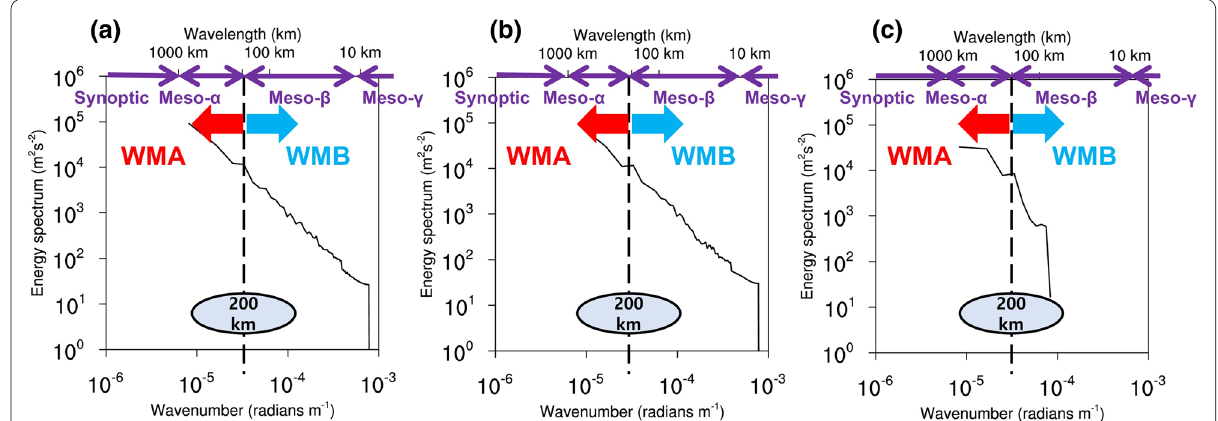
Fig. 3 Kinetic energy spectrum (m 2 s − 2 ) at different wavelengths (km) in a CTRL04, b LOW04, and c CTRL36, respectively. The kinetic energy with wavelengths longer (shorter) than 200 km is indicated by WMA